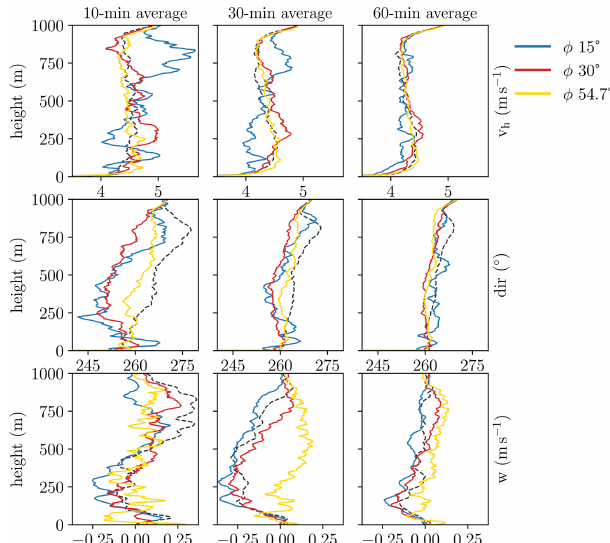
Figure 3. Simulation case 1: time-averaged vertical profiles of the three-dimensional wind vector of lidar scans with the VAD 24 tech- nique using different zenith angle configurations ( φ ). Displayed are horizontal wind speed (upper panels), wind direction (center pan- els) and vertical wind (lower panels). Different colors indicate dif- ferent zenith angle configurations. Reference profiles (true LES val- ues) along the vertical column directly above the lidar location are shown in black (dashed